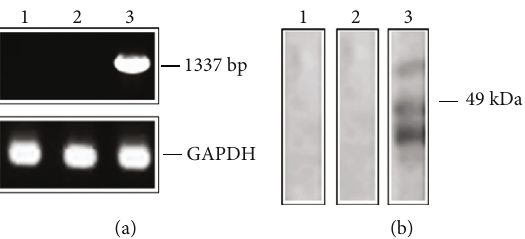
Figure 3: Expression of LmxMBA in transfected human HeLa cells. Nontransfected HeLa cells (1) and transfected with pVAX1 (2) or with pVAX1::LmxMBA (3) were assayed by RT-PCR (a) and immunoblotting (b) for the expression of LmxMBA 48 h